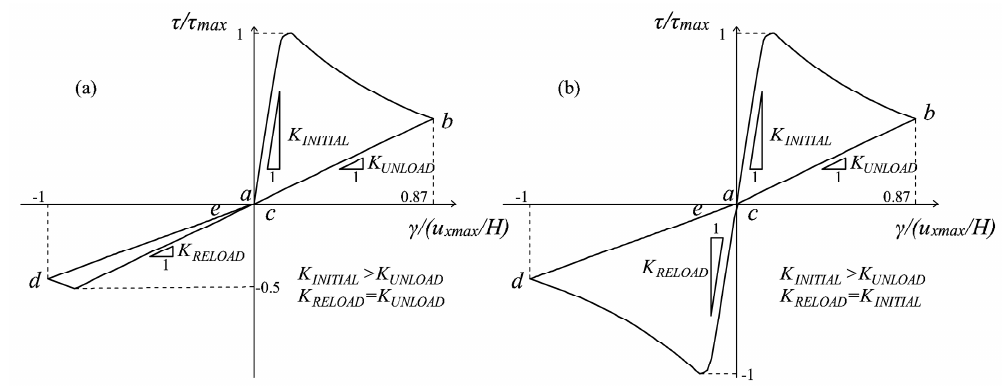
Figure 8. Structural response for the problem represented in Figure 4a: ( a ) damage formulation presented in Section 2 and ( b ) multidirectional damage model.